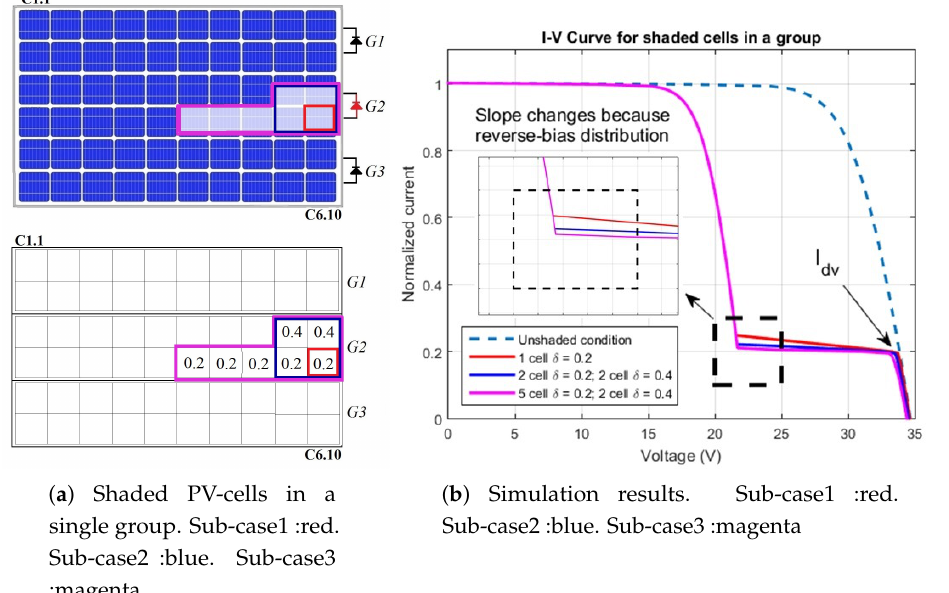
Figure 10. Representation of three sub-study cases with shadow patterns distributed in a single group.